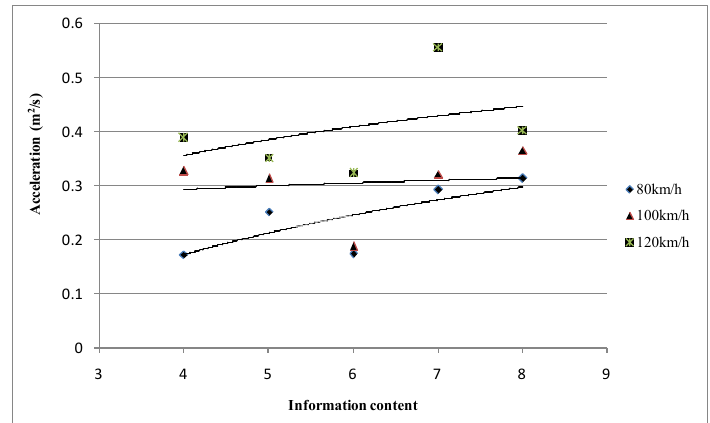
Fig.6. Correlation between Acceleration and information content under different driving